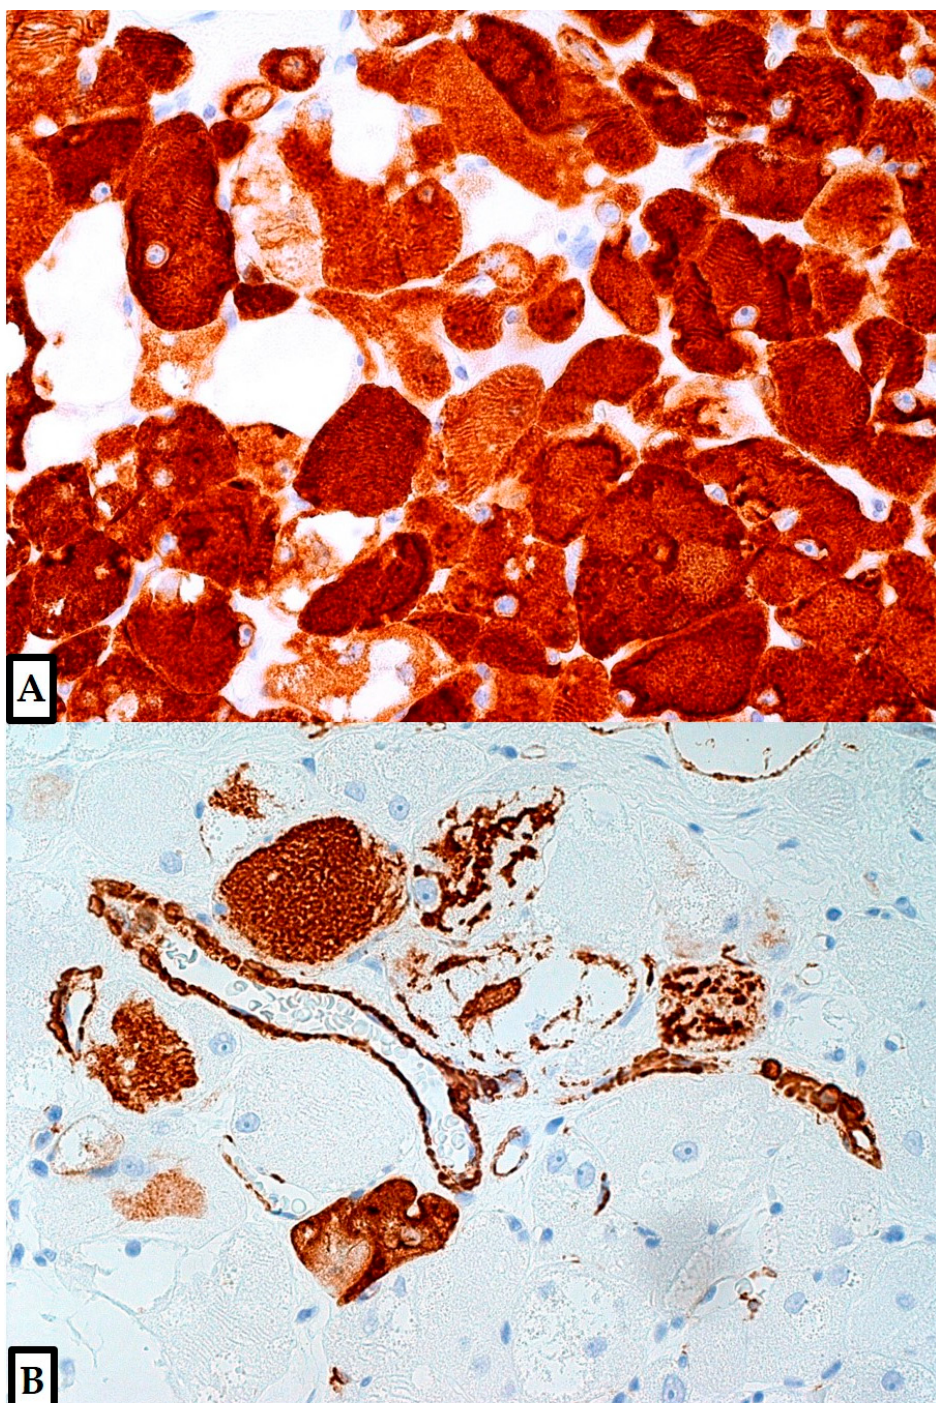
Figure 7. Additional markers had been previously performed, including melan-A (clone A103, mouse monoclonal, Ventana), CD68 (clones KP-1 and PG-M1, mouse monoclonal, Ventana), GFAP (clone 6F2, mouse monoclonal, Dako, Agilent Technologies, Santa Clara, CA, USA), pan-cytokeratins (clone AE1/AE3, mouse monoclonal, Dako), CEA (clone TF 3H8-1, mouse monoclonal, Ventana), calretinin (clone SP65, rabbit monoclonal, Ventana) and neurofilaments; they all resulted negative. Desmin and smooth muscle actin (SMA) were simultaneously tested in both our current and previous specimen; desmin resulted strongly positive in >98% of tumor cells (( A ); clone DE-R-11, mouse